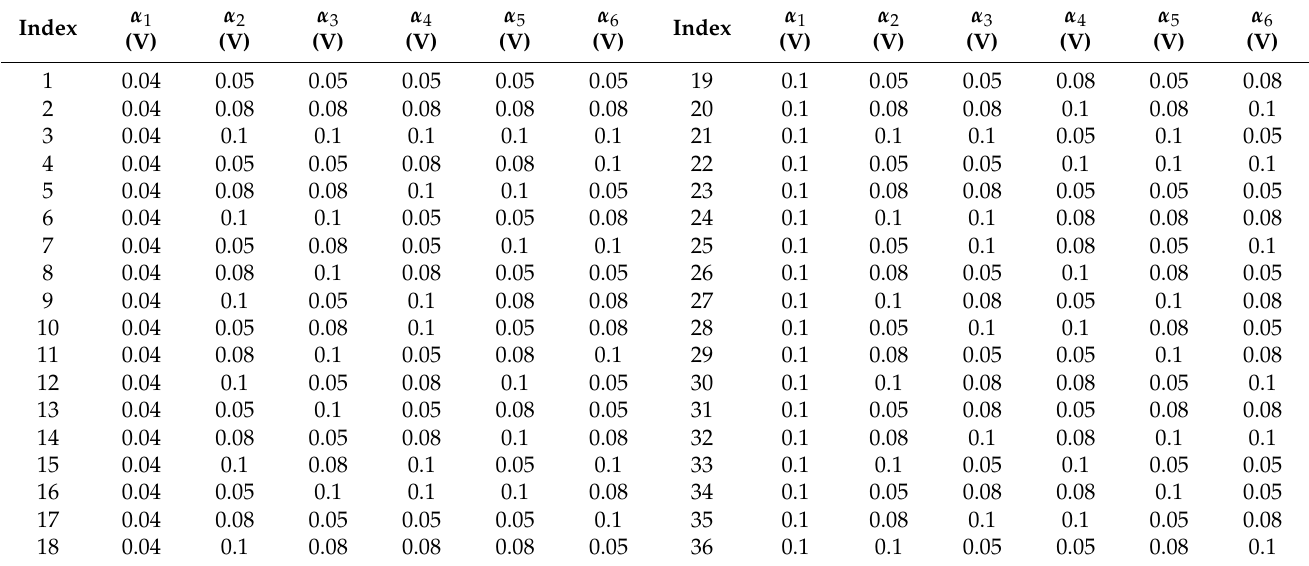
Table 4. Orthogonal design of experiments on interaction effects of